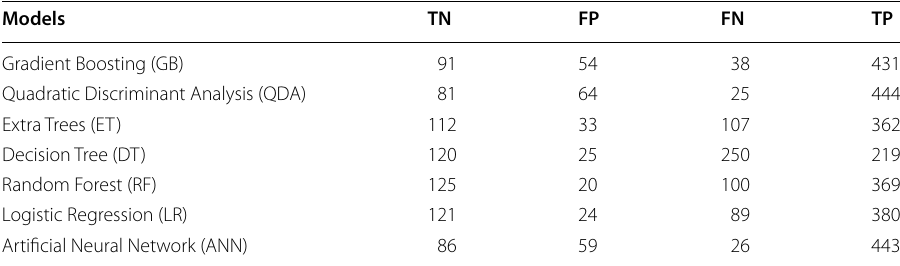
Table 7 Test statistics of the individual algorithms optimized with grid-search